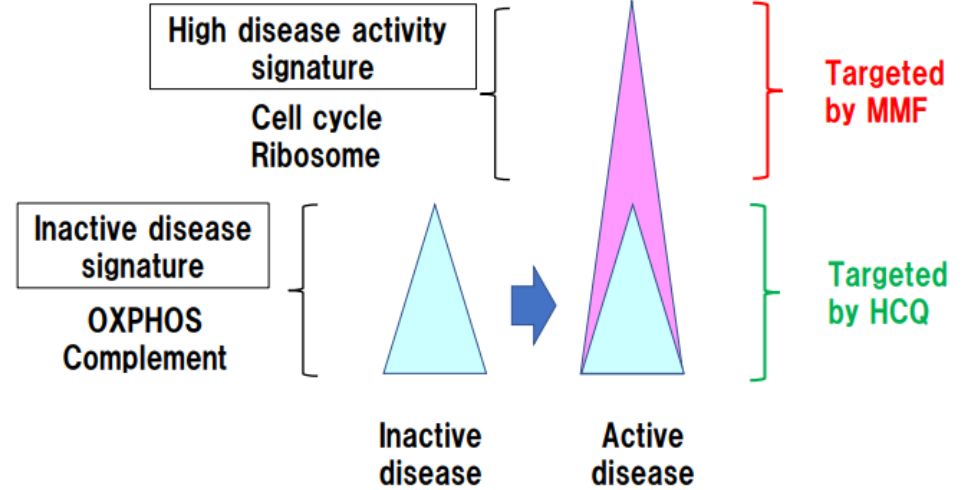
Figure 2. Two distinct signatures in SLE. Transcriptome analysis of SLE revealed that OXPHOS and complement pathways are the disease-state signatures upregulated in clinically stable SLE, and that the cell cycle and ribosomal pathways are the disease-activity signatures upregulated in active SLE. Interestingly, mycophenolate mofetil (MMF), an immunosuppressive drug effective in SLE, inhibited the cell-cycle pathway in the disease-activity signature. Hydroxychloroquine (HCQ) may suppress OXPHOS pathway in clinically stable SLE via inhibition of TLR signaling.